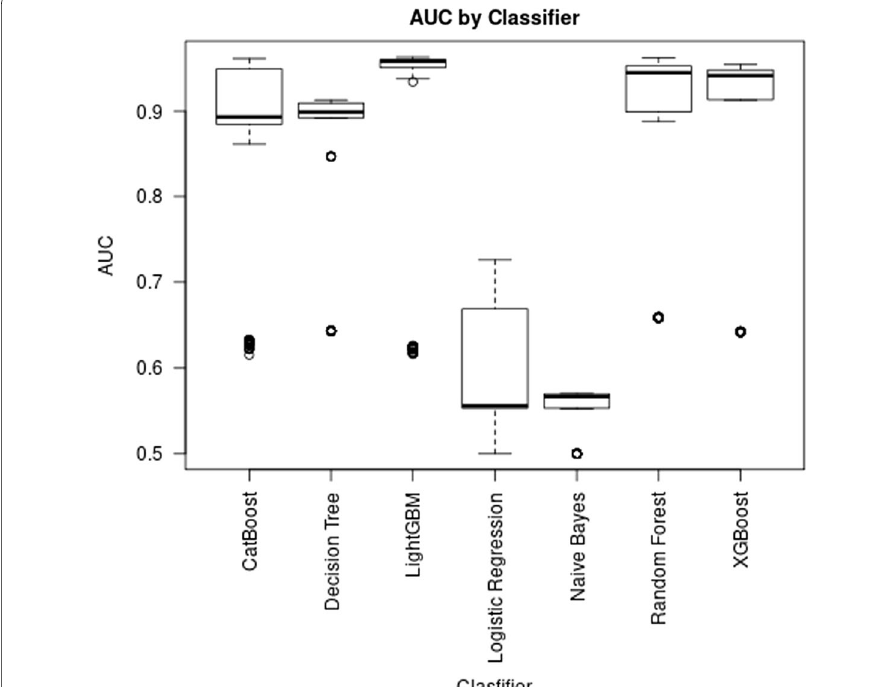
Fig. 1 Box plots of AUC grouped by classifier; here datasets do not include destination port; Tukey’s HSD test indicates LightGBM, Random Forest and XGBoost in group a, CatBoost, Decision Tree in group b, Logistic Regression in group c and Naive Bayes in group d (factors in the same group are not significantly